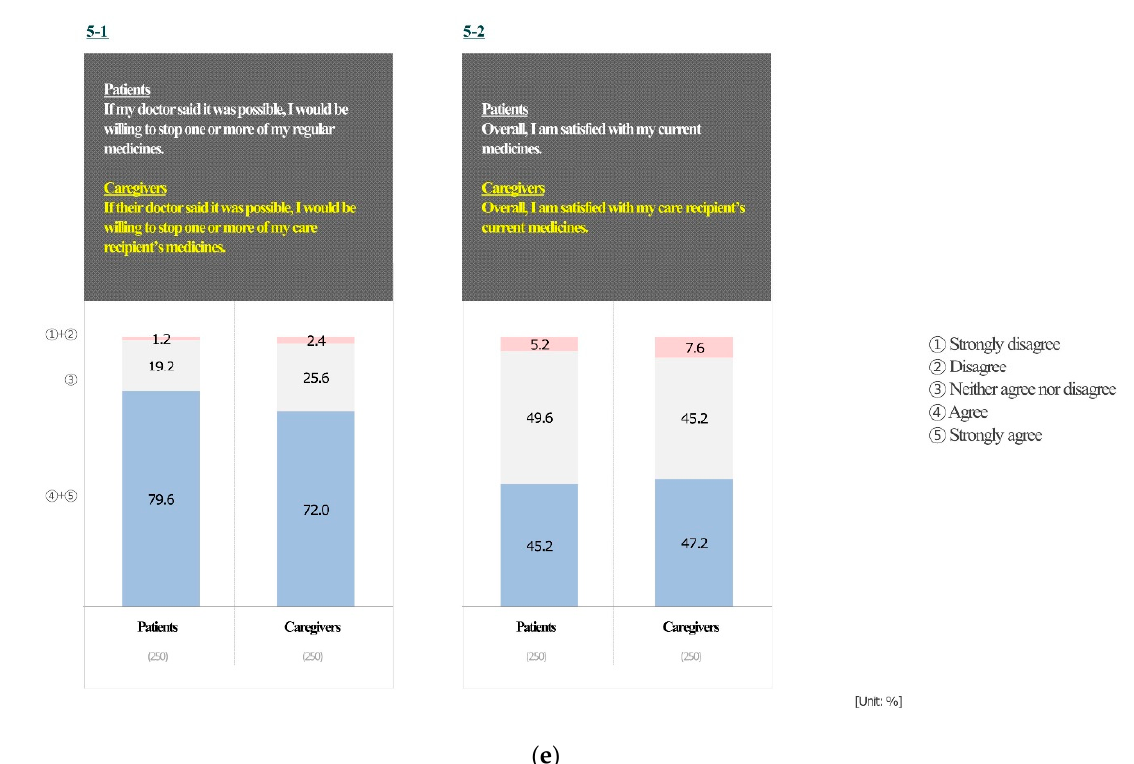
Figure 1. Overview of patients’ and caregivers’ responses to the rPATD questionnaire. ( a ) burden factor, ( b ) appropriateness factor, ( c ) concerns about stopping factor, ( d ) involvement factor, and ( e ) global factor.